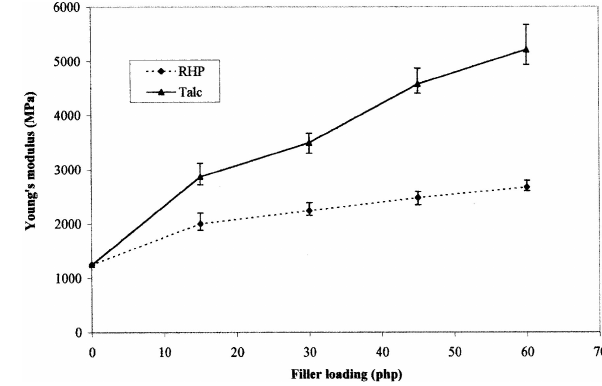
Figure 3: Variation of Young’s Modulus with fibre loading